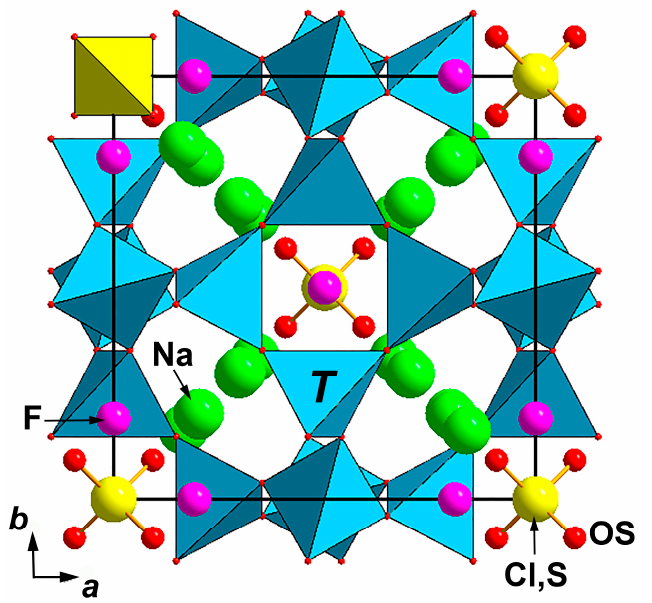
Figure 12. The crystal structure of the F-rich sodalite-group mineral (Sample 9).